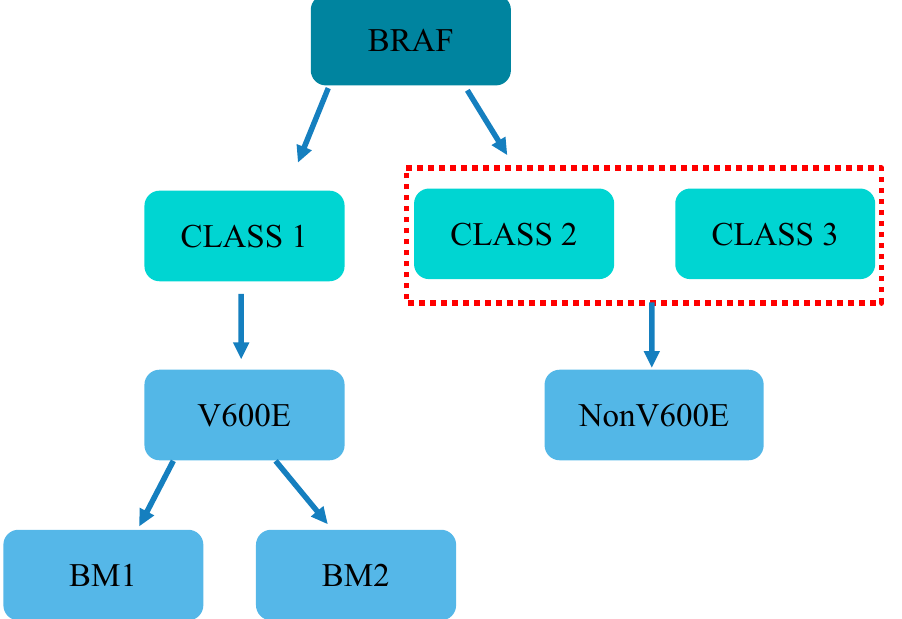
Figure 2. Classification and types of BRAF mutations.